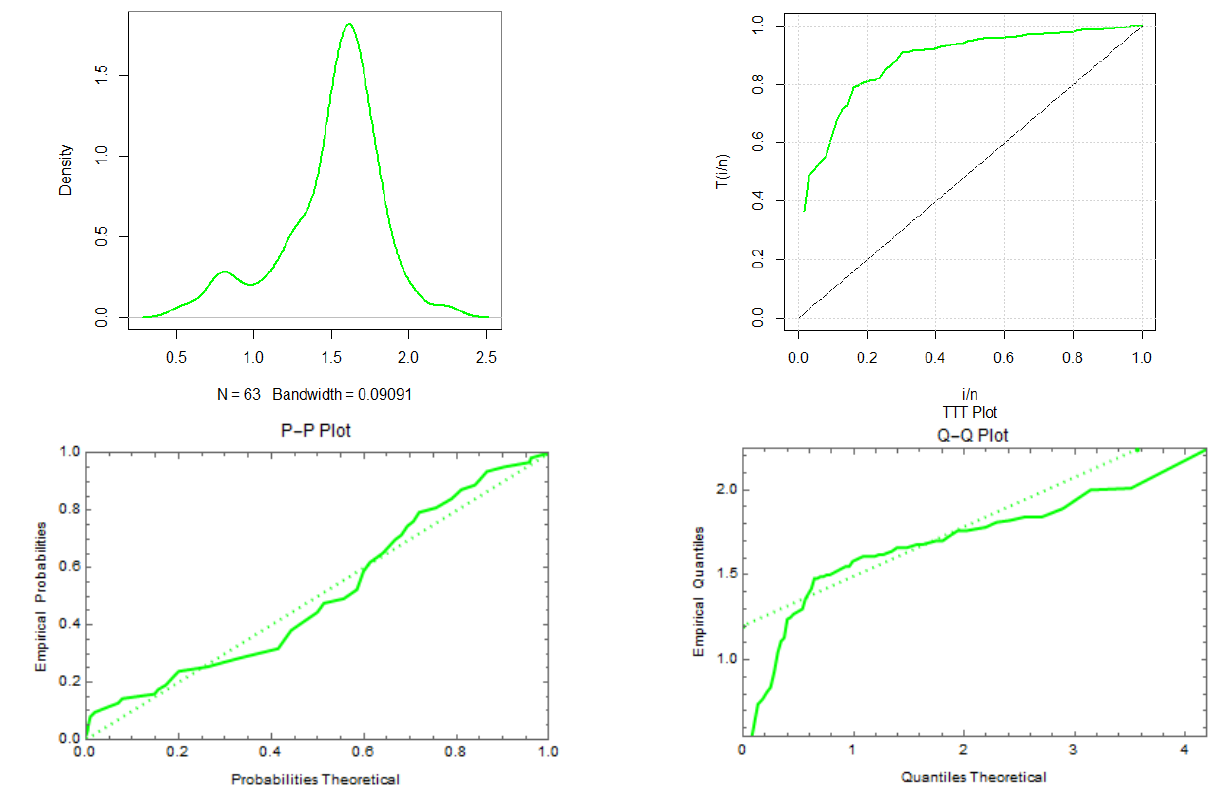
Figure 11. The density, TTT, P–P, and Q–Q plots of the PZD with glass fiber data.